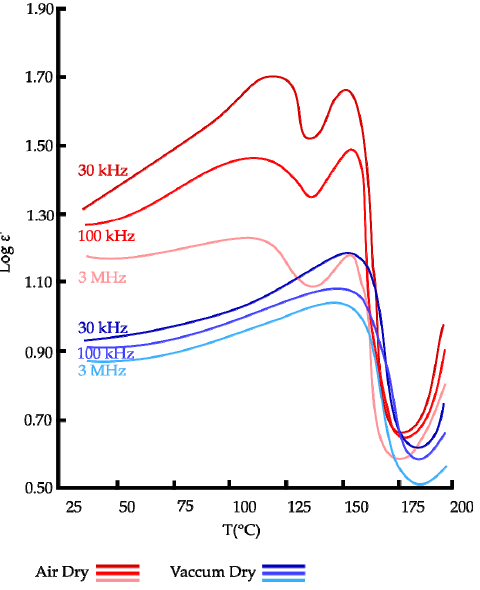
Figure 5. Temperature dependence of dielectric constant for air and vacuum dry keratin [41].